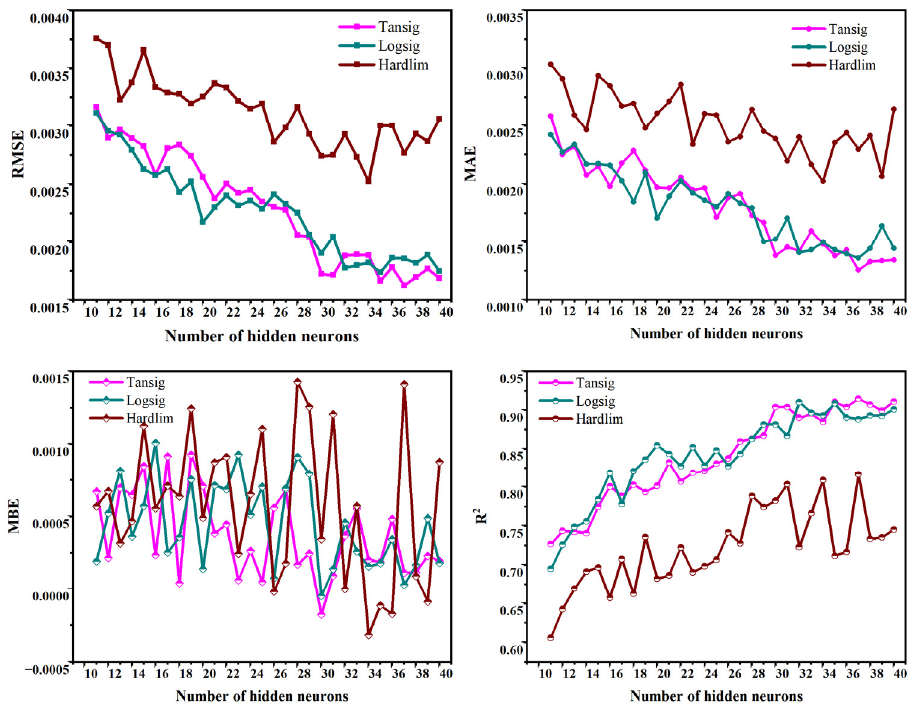
Figure 11. Statistical performance of the ELM model with different transfer functions and hidden neurons in the testing stage.